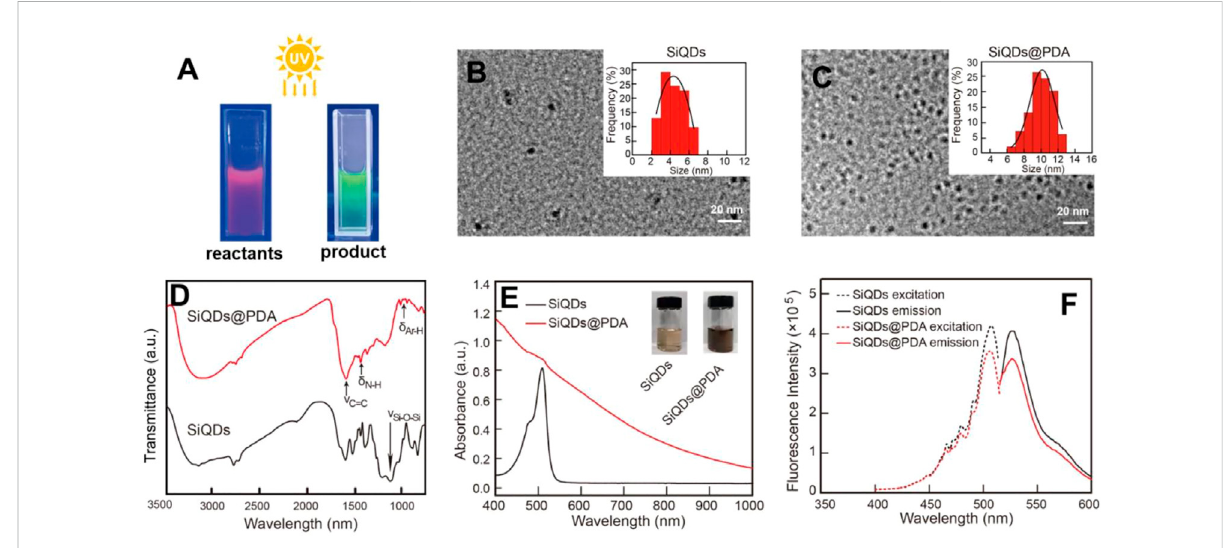
FIGURE 1 Characterization of SiQDs and SiQDs@PDA. (A) Digital images of the reactants in synthesizing the SiQDs fl uorescent probe in aqueous solution under UV lamp irradiation; (B,C) TEM images with statistical analysis of average diameter; (D) FTIR spectra; (E) UV-Vis spectra; and (F) excitation and emission fl uorescent